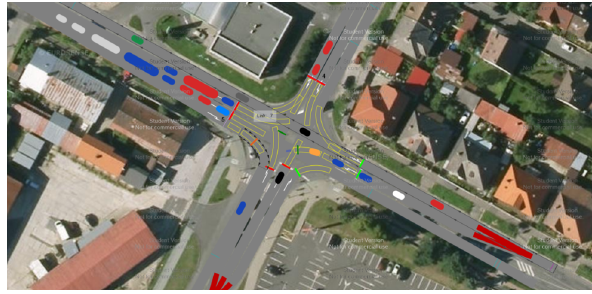
Figure 10: Driving directions from direction D after adding a new driving lane